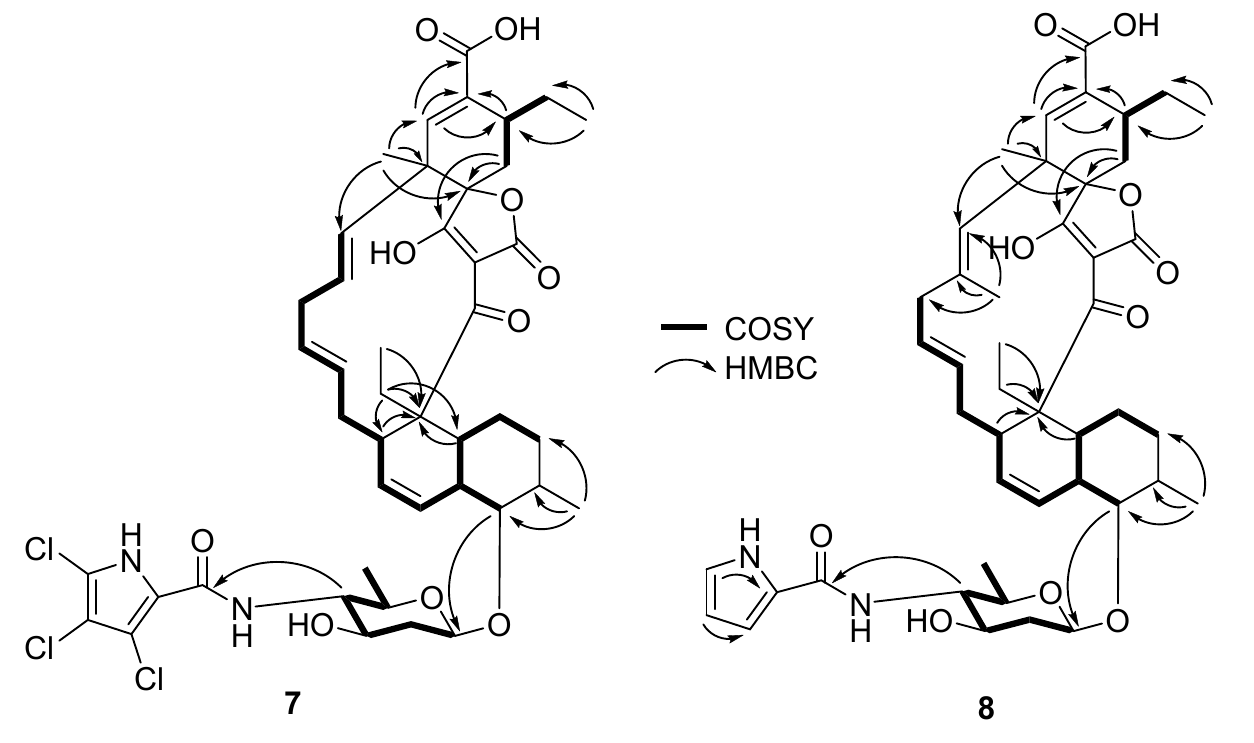
Figure 4. Selected HMBC and COSY correlations for 7 and 8 .